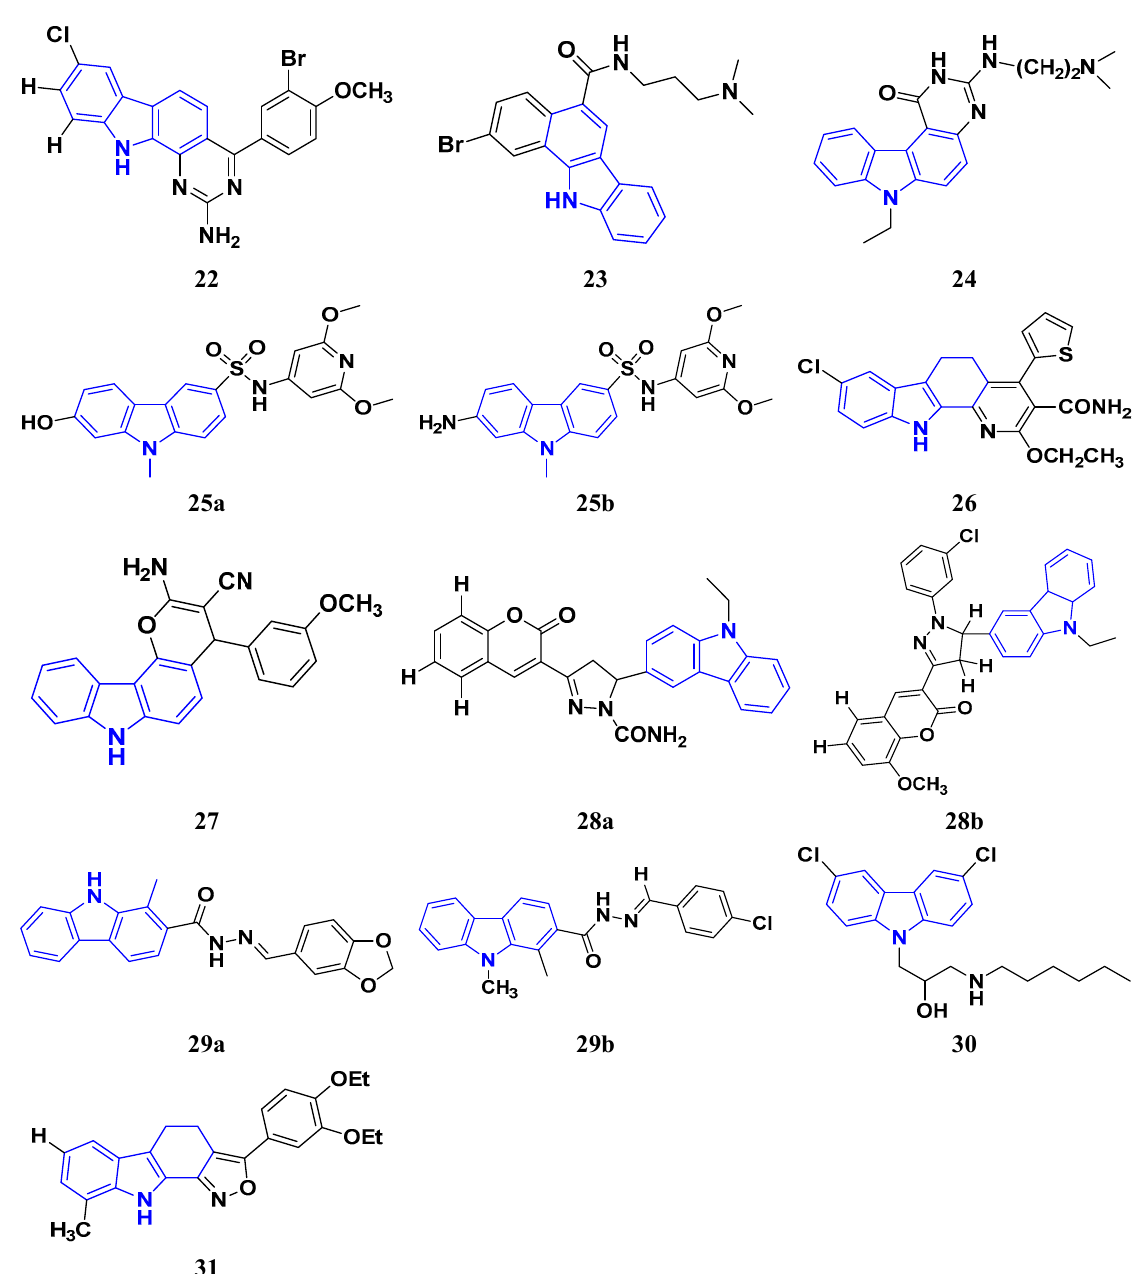
Figure 5. Carbazole derivatives ( 22 – 31 ) as anticancer agents.